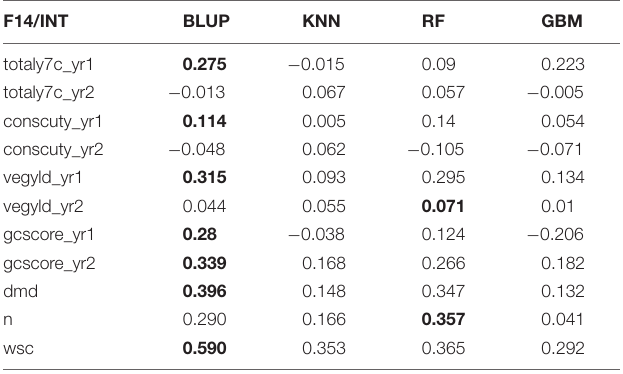
TABLE 3 | Correlation between observed phenotyped and GEBV predicted by the four methods trained on INT (Intermediate F11 + F12 + F13). F14/INT BLUP KNN RF GBM